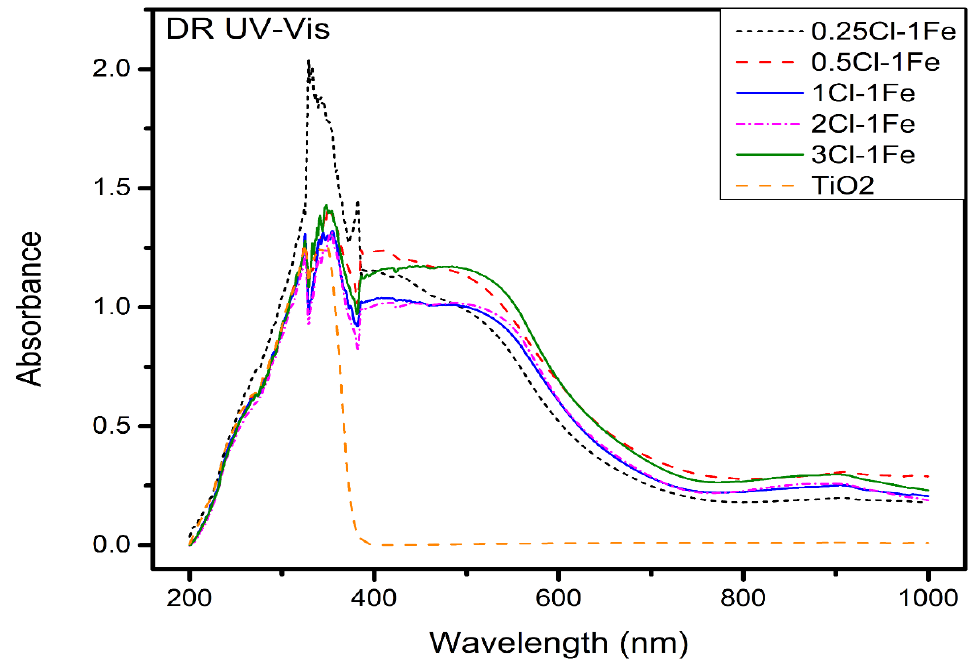
Figure 3. DRS UV–Vis for Fe–0.25Cl, Fe–0.5Cl, Fe–1.0Cl, Fe–2.0Cl and Fe–3.0Cl oxide